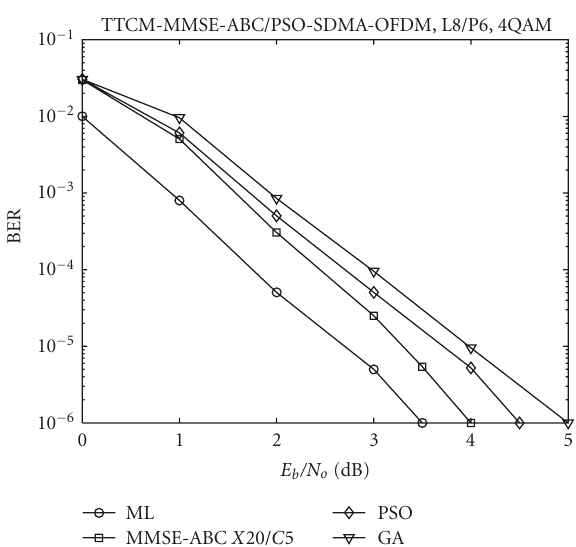
Figure 6: BER versus E b /N o performance comparison of 8 × 6 system for 64-QAM